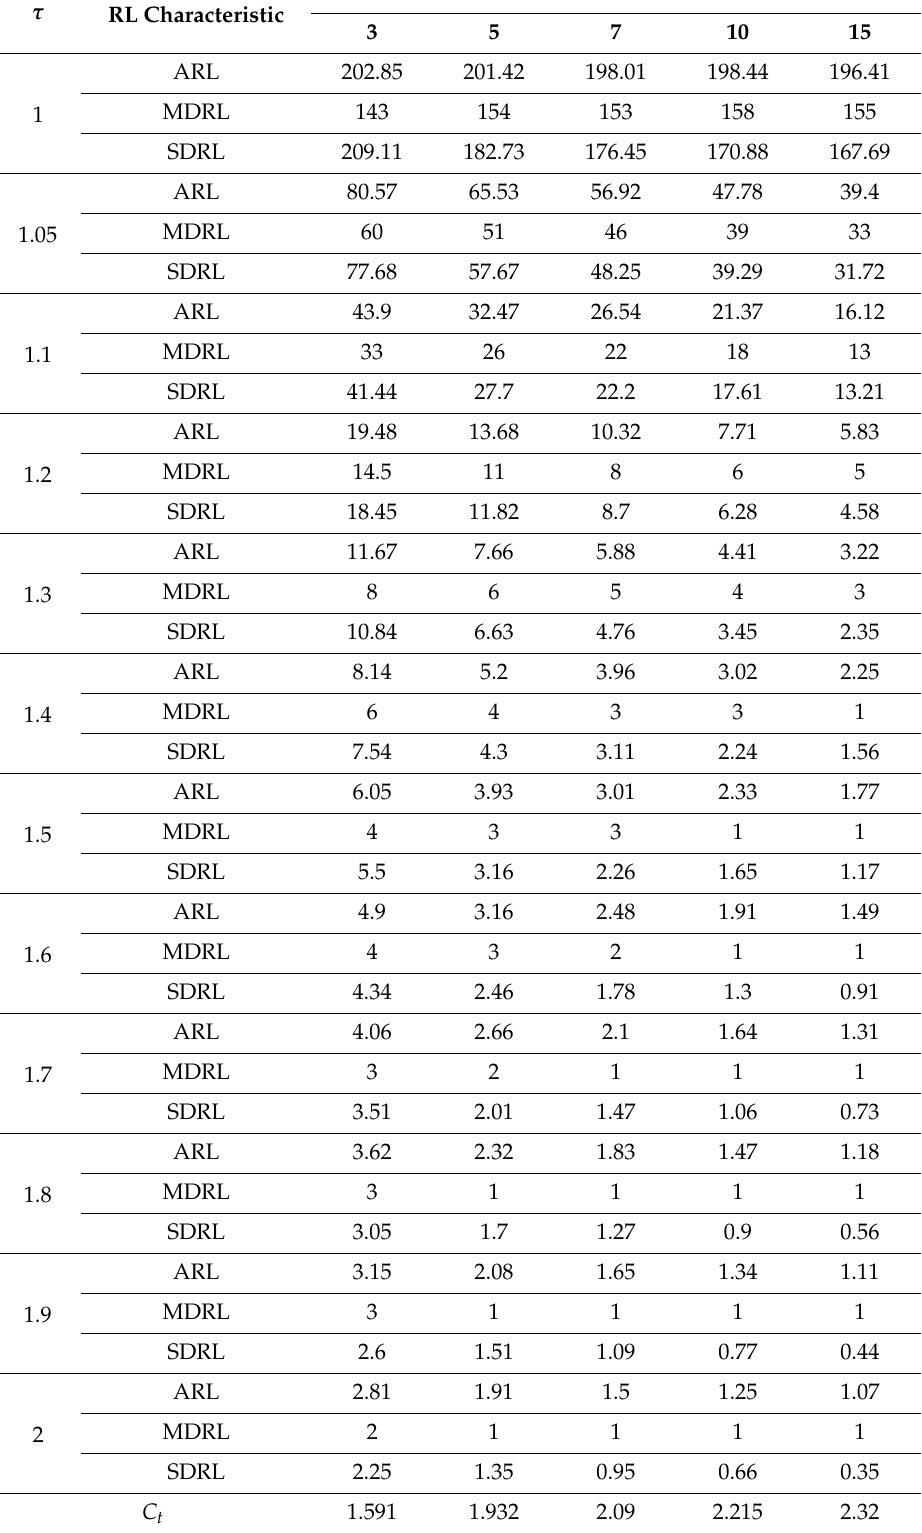
Table 2. The RL profiles of the proposed chart under various choices of n for λ =